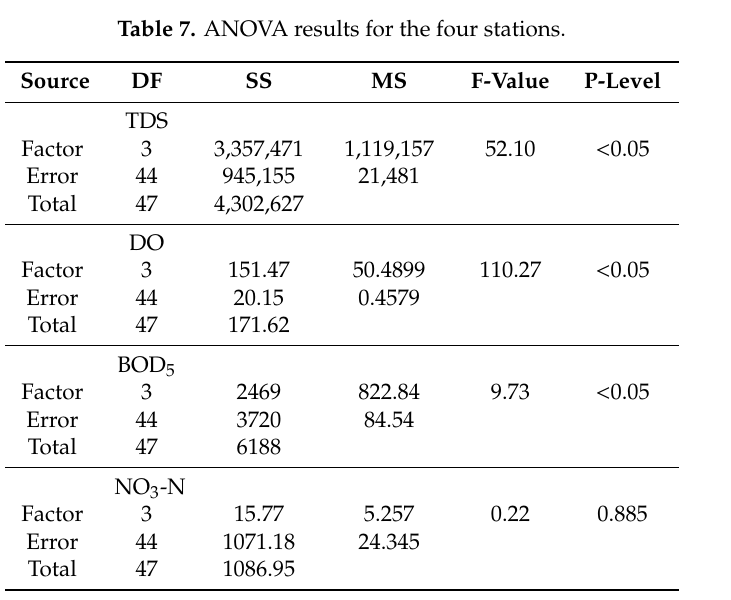
Table 9. Comparison of the official current situation and the indices ’ values at the four stations over the period from September 2013 to August 2014.